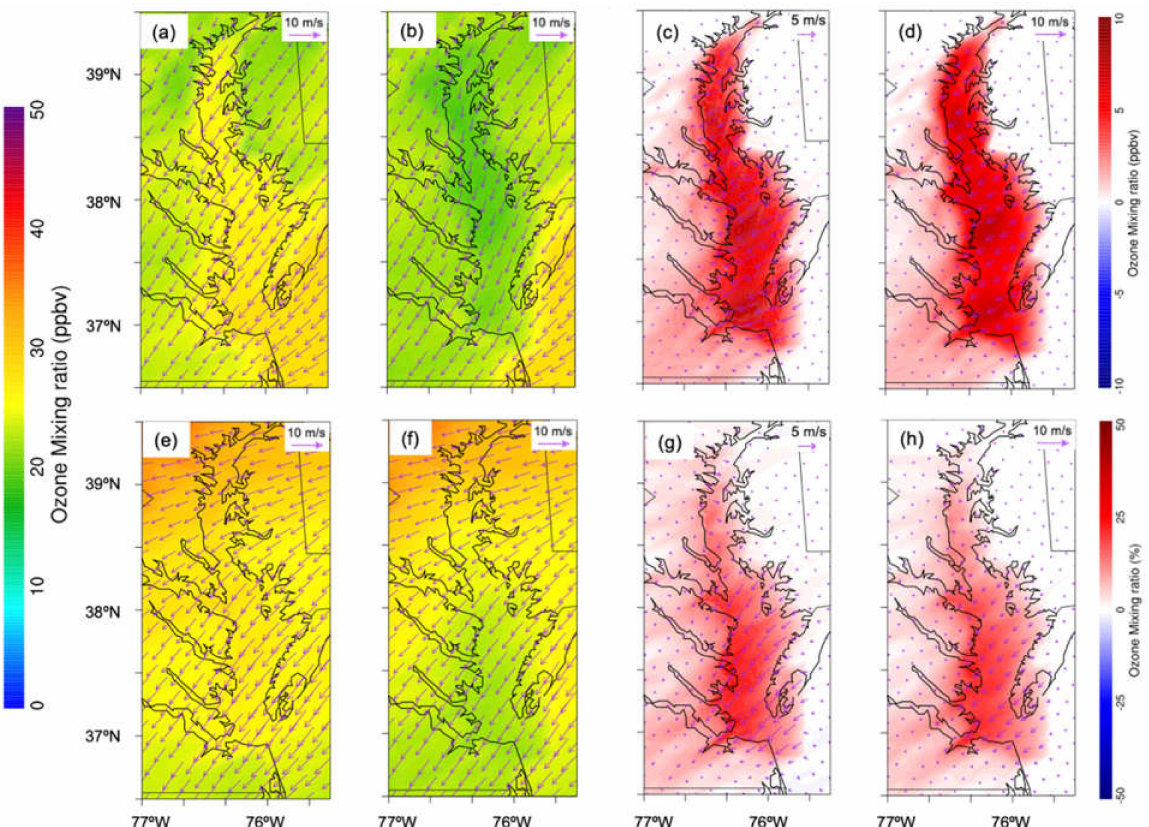
Figure 7. WRF–Chem modeled O 3 mixing ratio and absolute and relative O 3 mixing ratio difference between water and nowater (water minus nowater) for both nighttime ( a , c ) and daytime ( b , d ). ( a ) O 3 mixing ratio with water at night. ( b ) O 3 mixing ratio with nowater at night. ( c ) Absolute O 3 mixing ratio difference at night. ( d ) Relative O 3 mixing ratio difference at night. ( e ) O 3 mixing ratio with water in the daytime. ( f ) O 3 mixing ratio with nowater in the daytime. ( g ) Relative O 3 mixing ratio difference in the daytime. ( h ) Same as ( c ) but in the daytime. The wind vector arrow is shown in the top-right corner; wind units, m s − 1 . Daytime is defined as 1000–0000 UTC (or 06:00–20:00 local time); nighttime is defined as 0000–0900 UTC (or 00:00–06:00 and 20:00–00:00 local